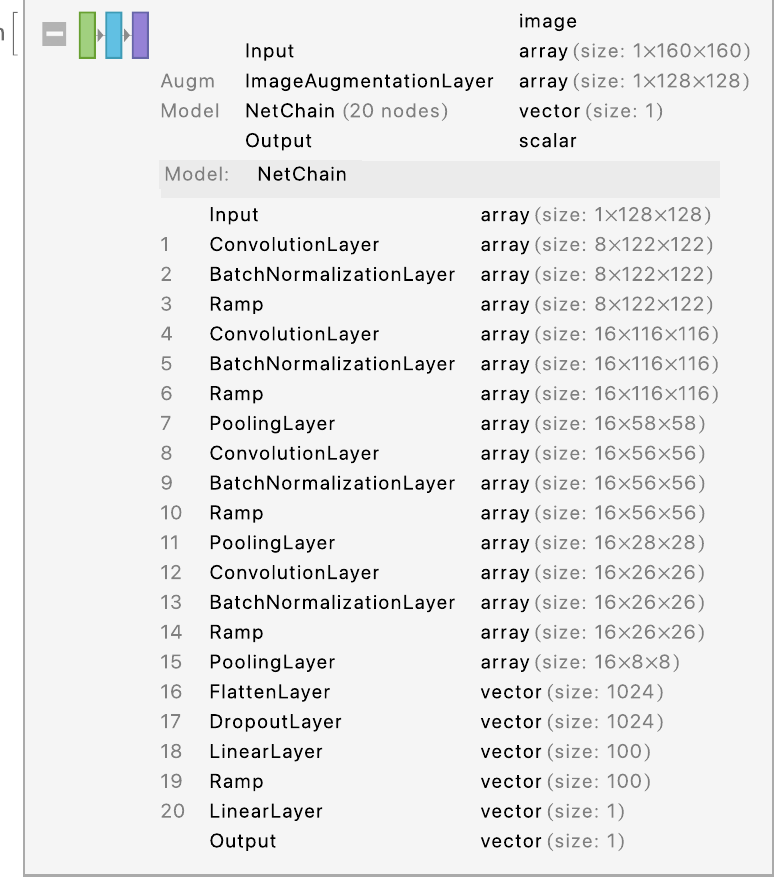
Figure 6. NN-based estimator. The image shows a neural network structure used to estimate age based on the input image. The network consists of multiple layers, where the convolutional layers are mainly responsible for handling the low-level patterns in the image, feature extraction and dimension reduction. The top layers (18–20) are responsible for building high-level relations among the